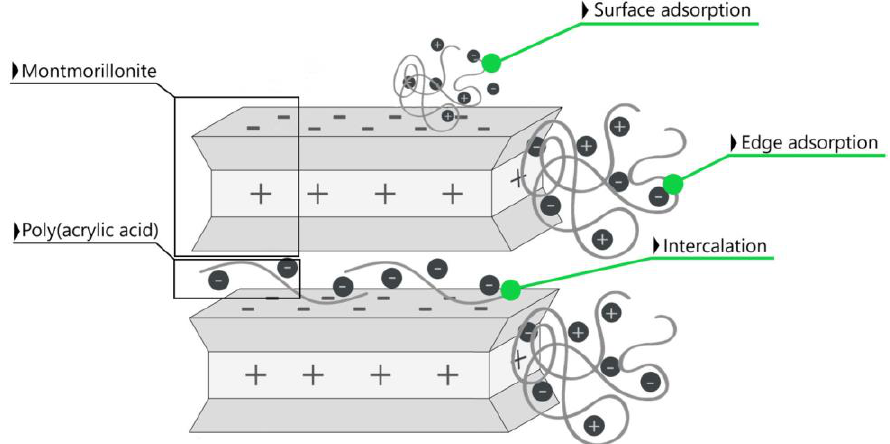
Figure 1. Scheme of some of the possible interactions of montmorillonite in calcium and sodium- activated bentonite with the chains of poly(acrylic acid): surface and edge adsorption combined with the intercalation [15].